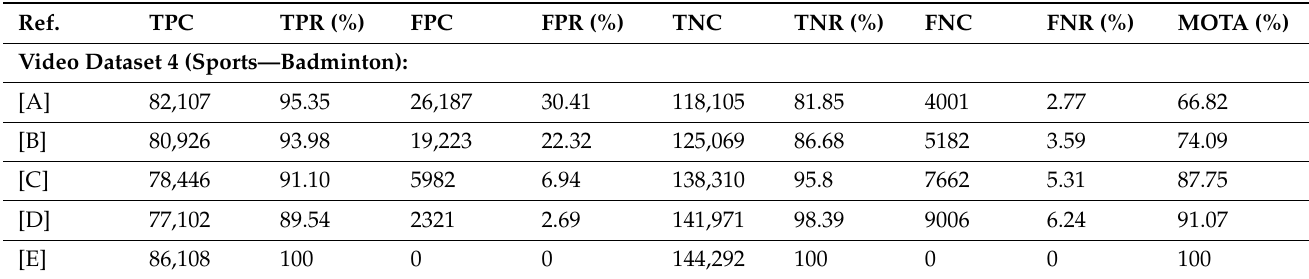
Table 4. Comparison of performance parameters by different approaches tested on video dataset 4: [A] by Pan et al. in [12]; [B] by Mehboob et al. in [13]; [C] by Indu, S. in [14]; [D] our proposed approach; [E] the true data obtained using markers.